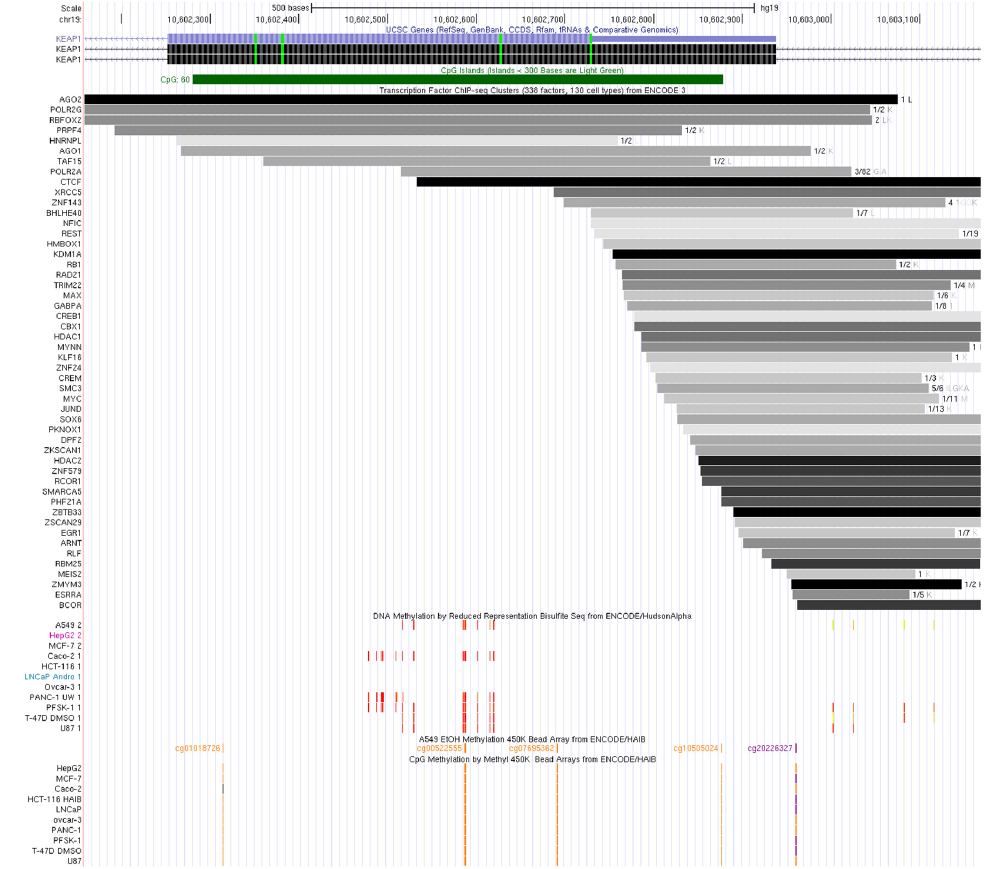
Figure 6. Schematic representation of KEAP1 exon 3 (hg19 genome sequence). From top to bottom: NCBI RefSeq and Consensus CDS UCSC tracks for KEAP1 exon/intron structure; TFBSs from the ENCODE Project; predicted CpG islands; detected methylation sites. The gray scale intensity of TF binding sites is proportional to the signal strength in the different tested cell lines (darker color indicates stronger signal). Red-orange bars indicate strong methylation signals; orange and blue bars indicate strong methylated vs . unmethylated status in 450K bead array experiments.